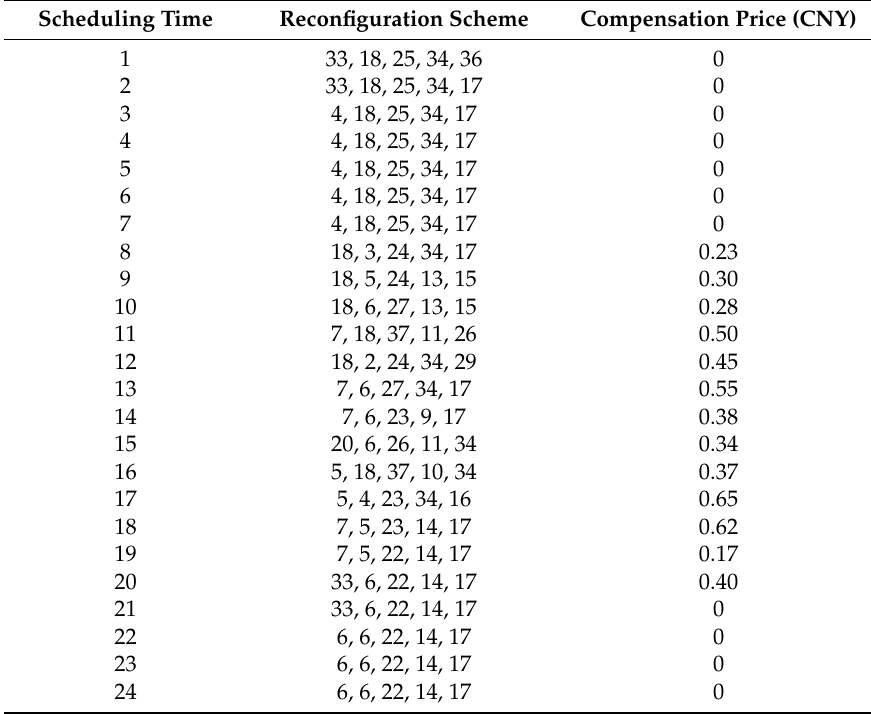
Table A2. Reconfiguration and compensation